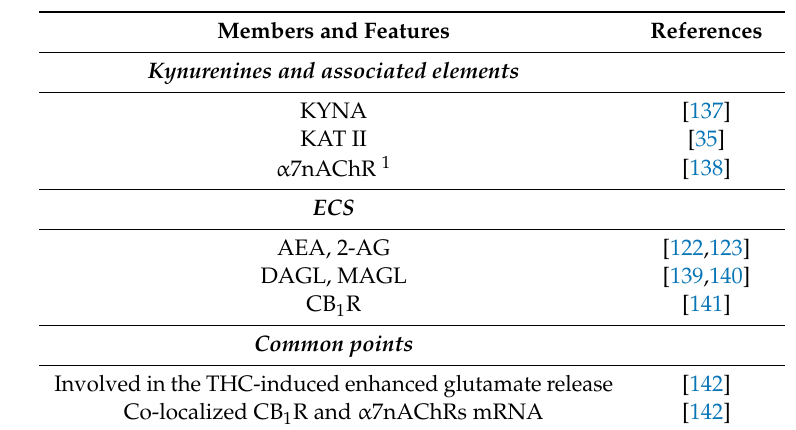
Table 3. Kynurenines and associated elements (enzymes, receptors) and members of the ECS present in astrocytes and involved in schizophrenia. The table also highlights the common points between the two